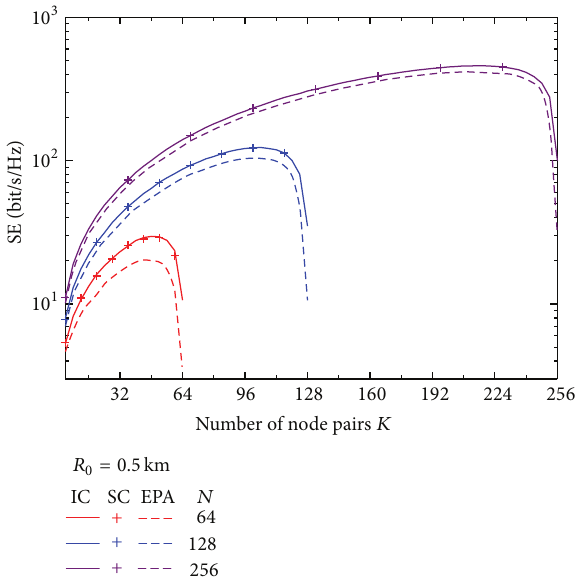
Figure 6: SE versus the number of node pairs 𝐾